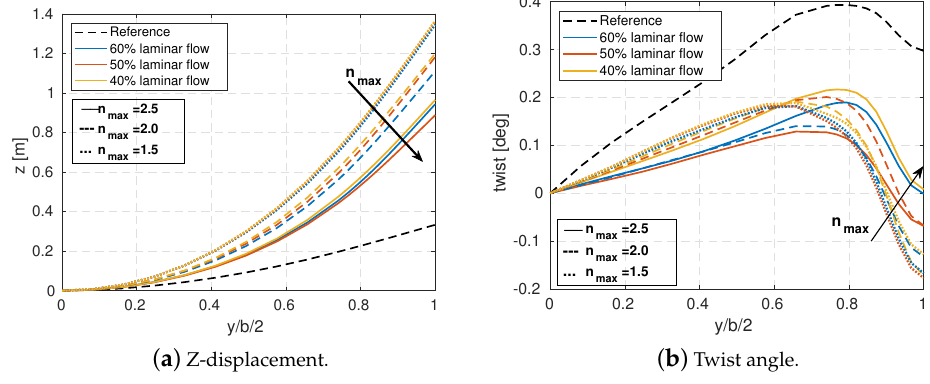
Figure 16. Forward-swept aeroelastic